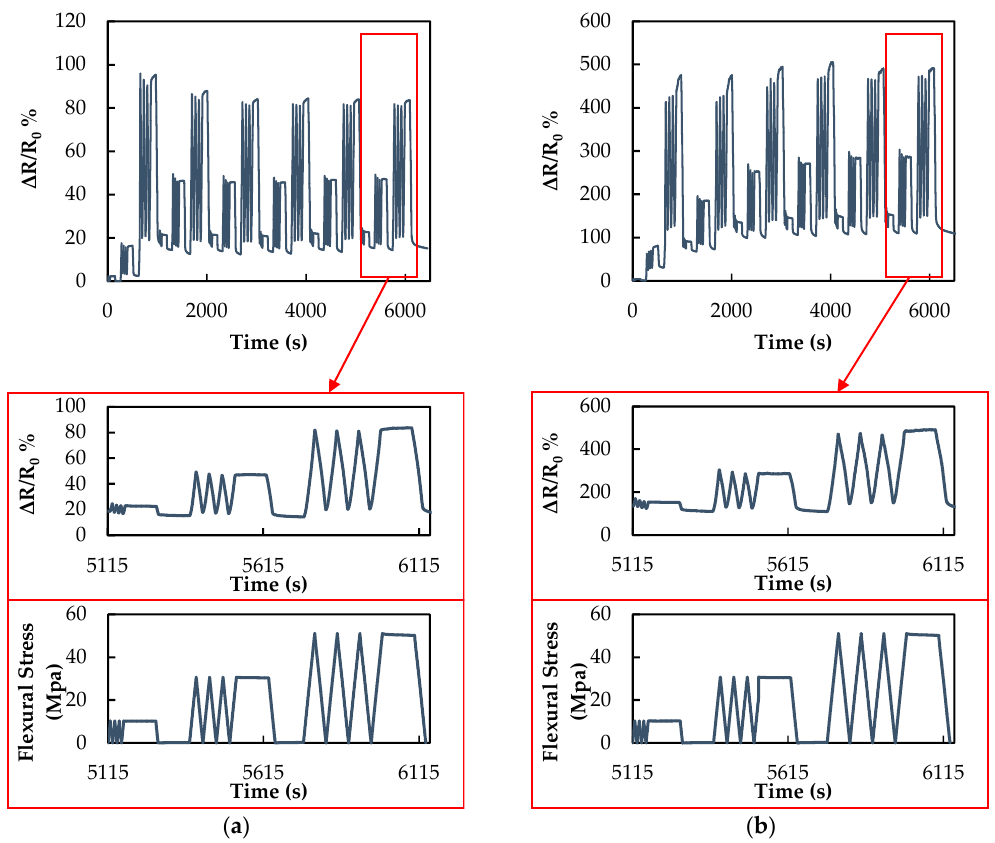
Figure 7. ( a ) normalized variation of electrical resistance ∆ R / R 0 % and flexural stress during strain cycling for a sensor produced via the capillary rise method; ( b ) normalized variation of electrical resistance ∆ R / R 0 % and flexural stress during strain cycling for the sensor produced via the resin casting method.